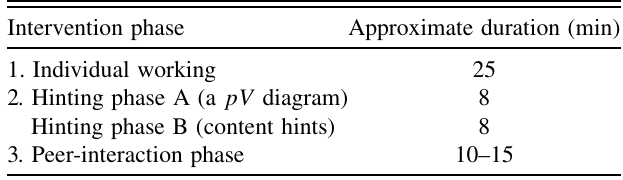
TABLE II. Atimeallocation forthe